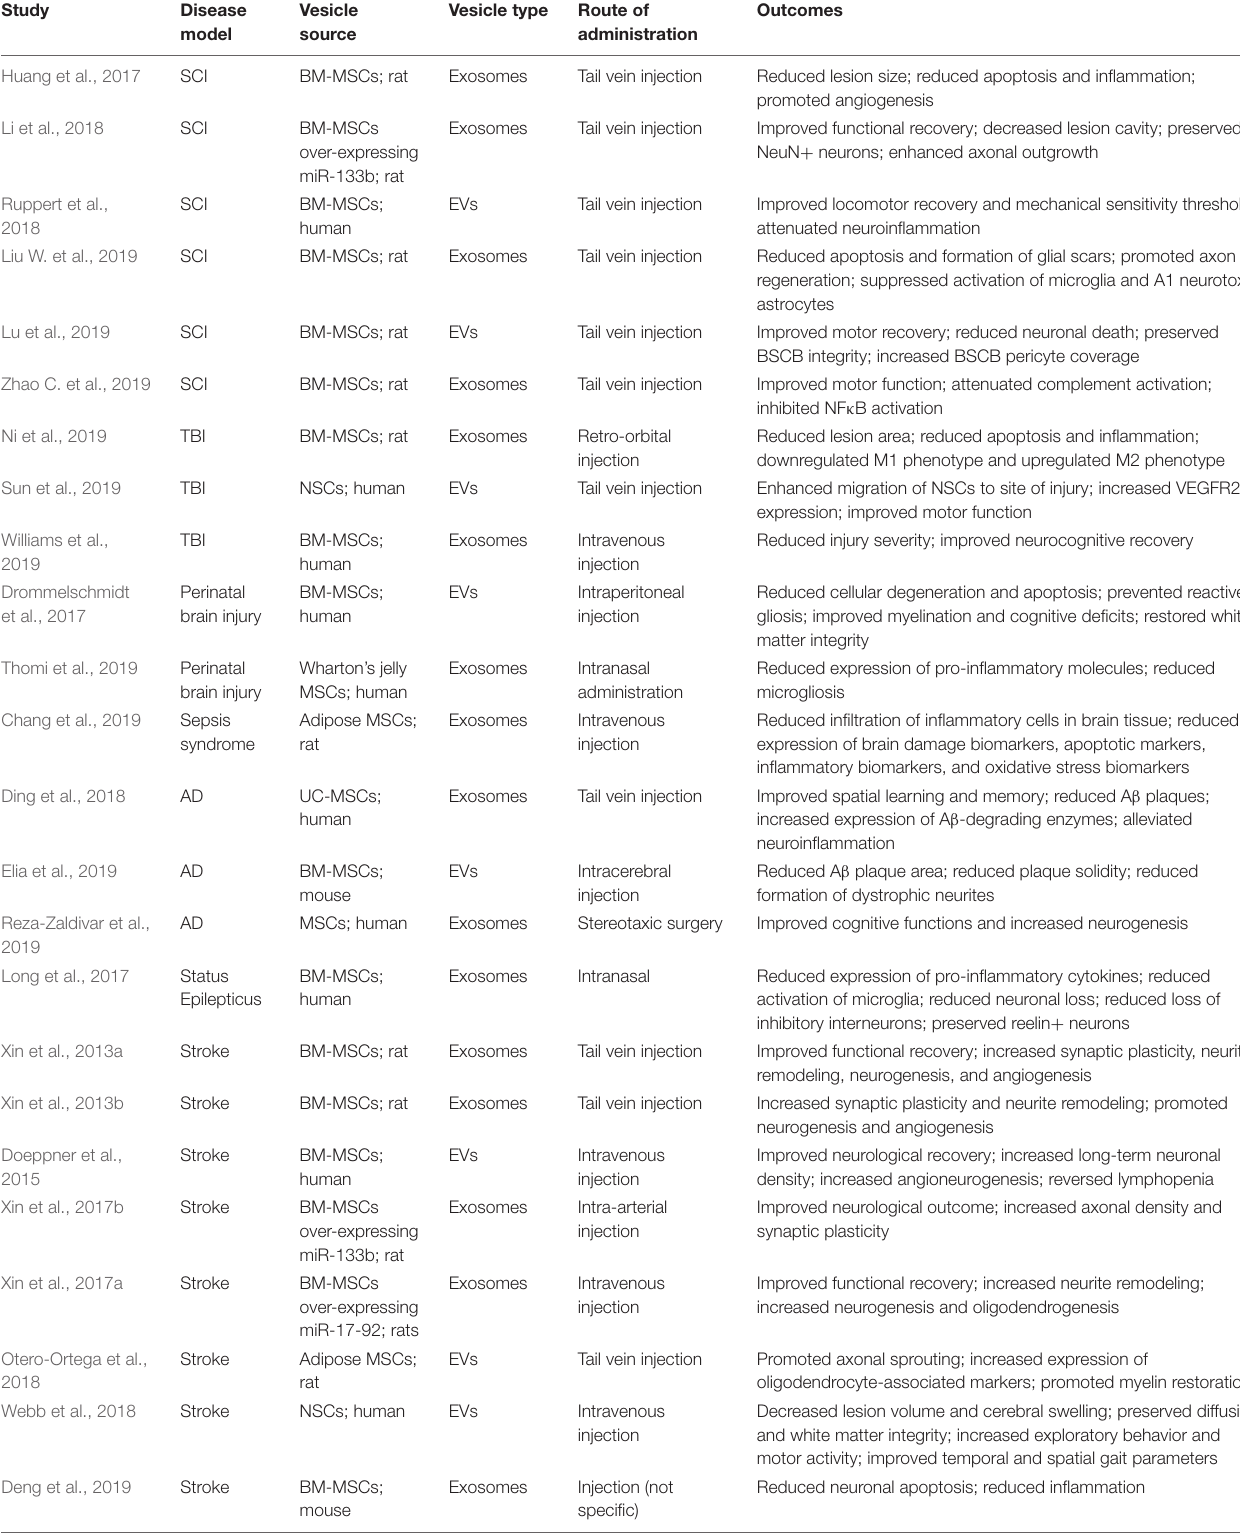
TABLE 2 | In vivo studies using stem cell EVs for CNS-related